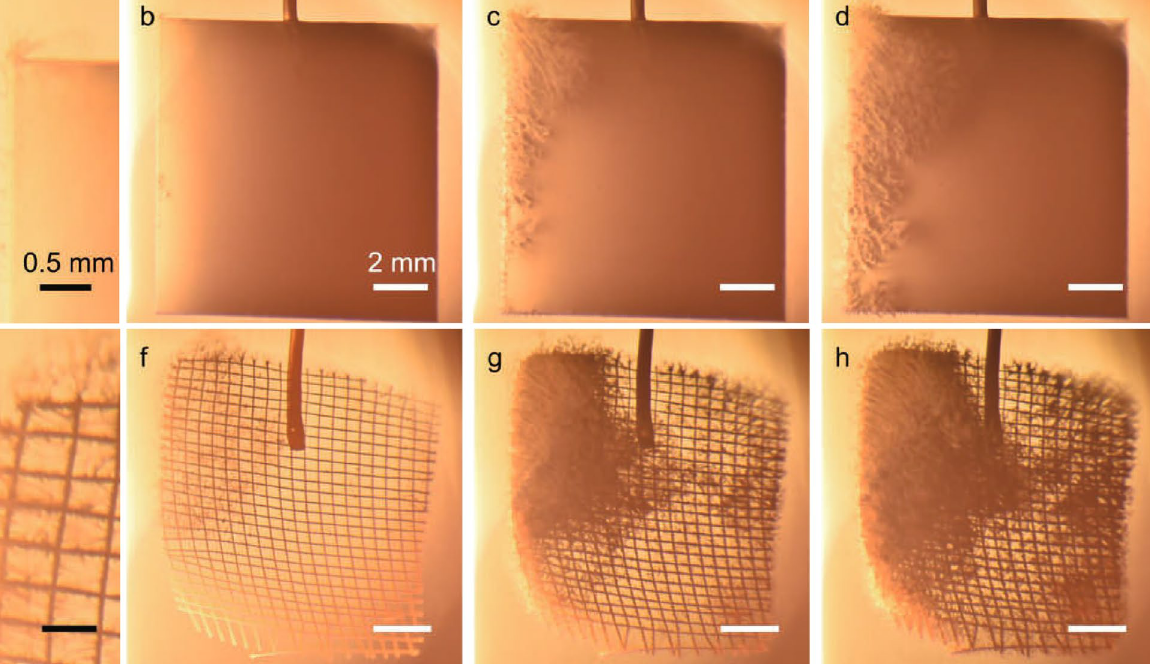
Figure 3. Images representing the formation process of LFNs on ( a – d ) the W-plate and ( e – h ) on the ♯ 50 W mesh, taken by an optical camera during plasma irradiation: ( a ) magnified view of LFN formation on the W plate at 20 min, ( b – d ) total view of the W plate at 20, 40, and 60 min, respectively, ( e ) magnified view of LFN formation on the ♯ 50 W mesh at 20 min, and ( f – h ) total view of the ♯ 50 W mesh at 20, 40, and 60 min,